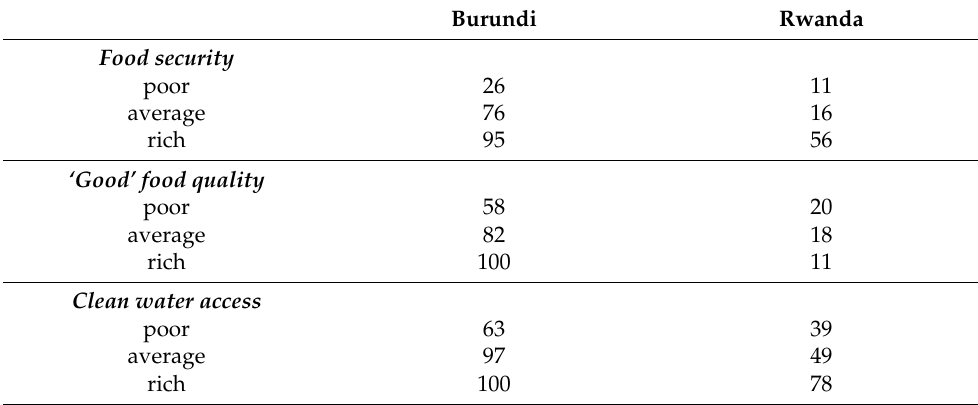
Table 4. Households’ food security, ‘good’ food quality and access to clean water (during the previous year) according to wealth groups around Kibira in Burundi (n = 150) and Nyungwe in Rwanda (n = 150). % refers to the % of respondents within each wealth group in that study